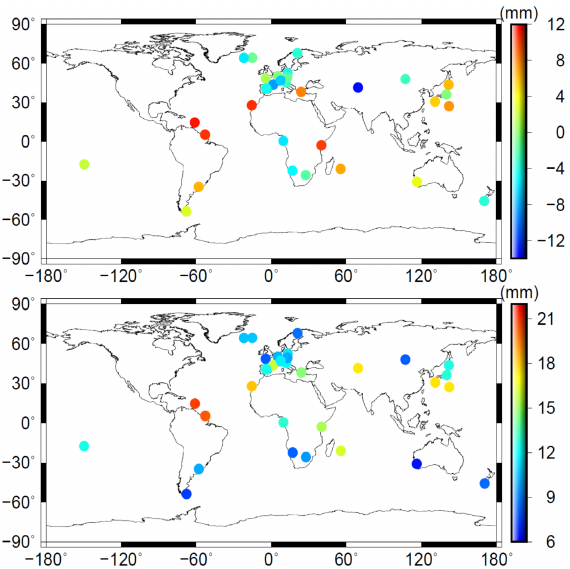
Figure 5. The map of the station-specific mean biases (top) and rms values (bottom) of ZTD differences between ECMWF and IGS for DOY 244–272, 2015.